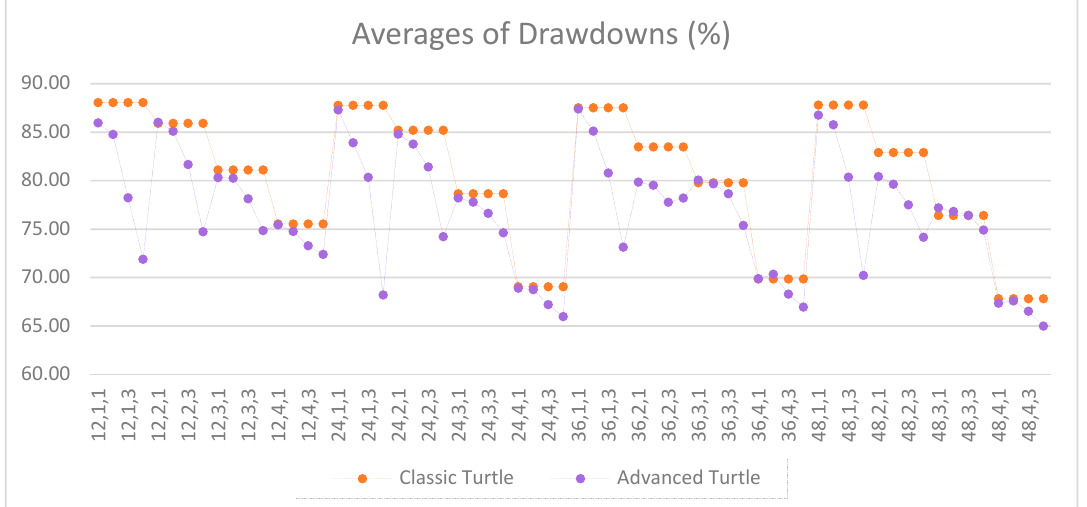
Figure 9. Averages of profits between the classic and the advanced Turtle systems for every combination of N, X, Y for the fast parameters (20, 40).